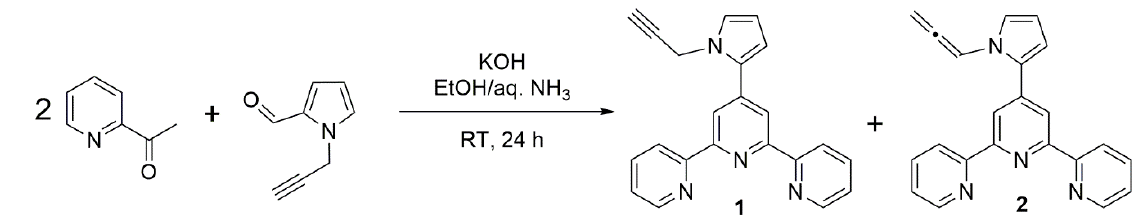
Figure 3. Reaction scheme.